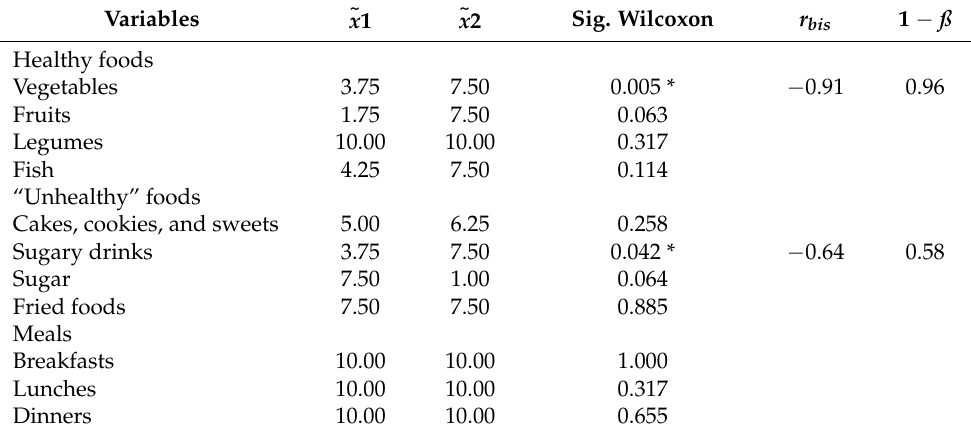
Table 4. Wilcoxon test applied to food parameters evaluated in ePSICONUT.